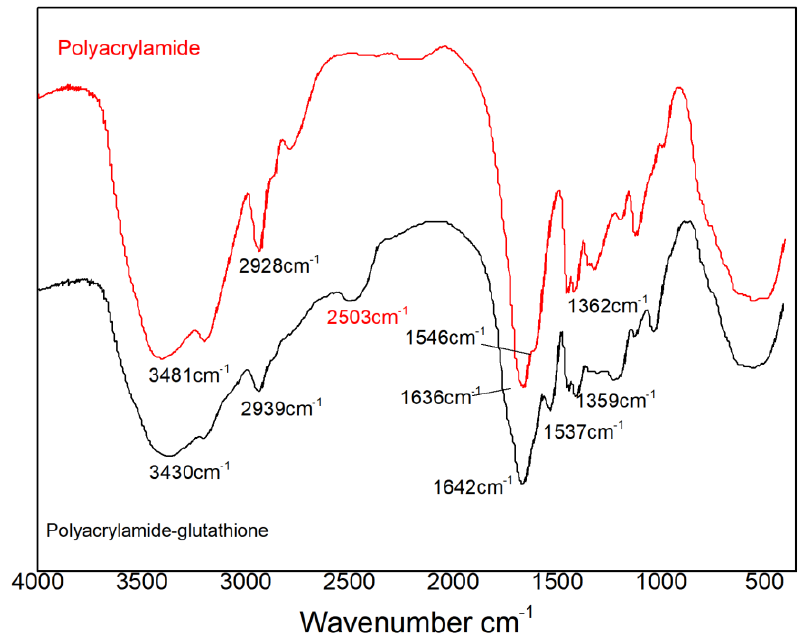
Figure 4. Comparison of FTIR spectra of polyacrylamide before (Red curve) and after grafting glutathione (Black curve).